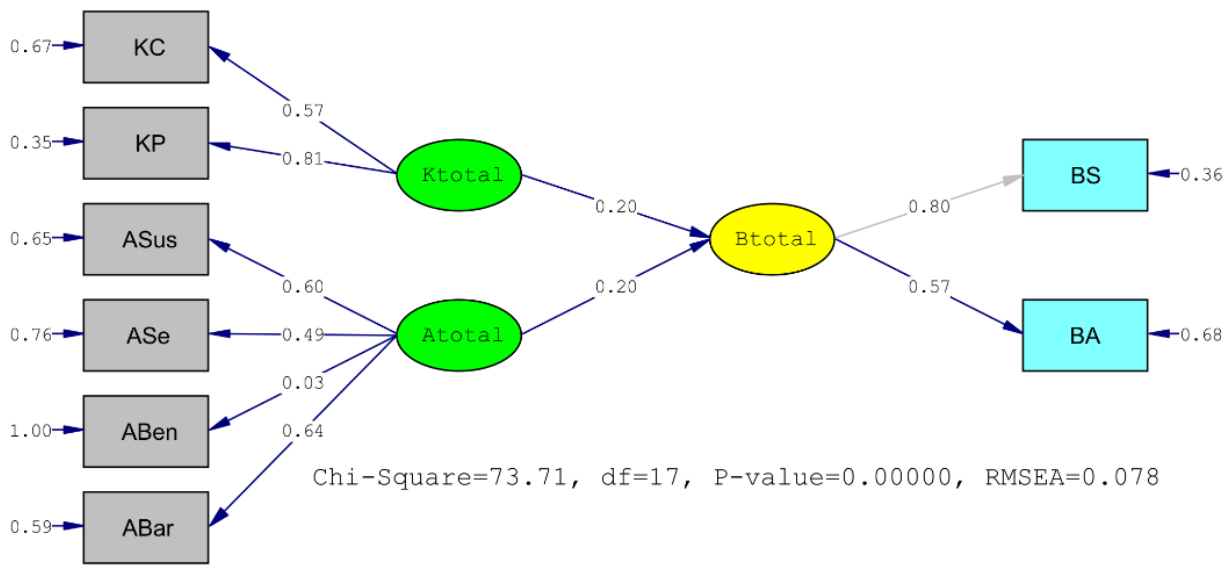
Figure 2. The Relationship Between Knowledge, Attitude and Behavior Scales, Structural Equation Modeling Analysis. RMSEA: The Root Mean Square Error of Approximation .